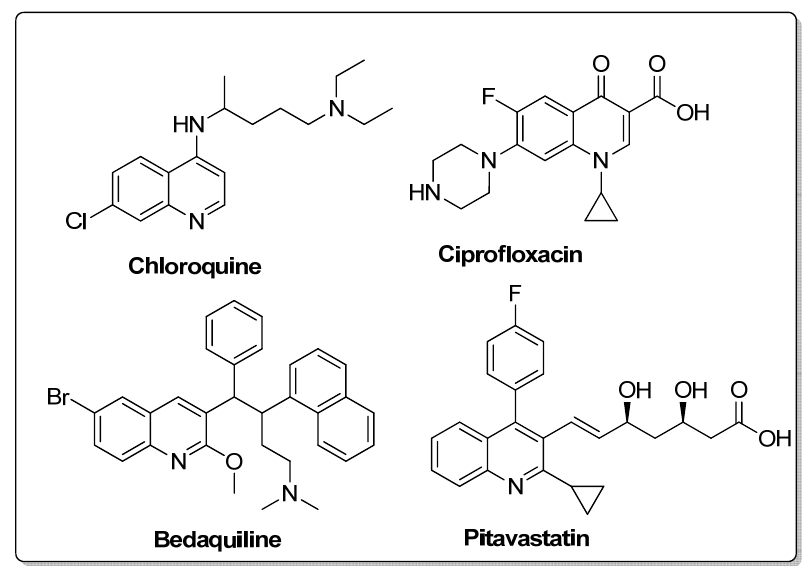
Figure 33. Quinoline clinical drugs.